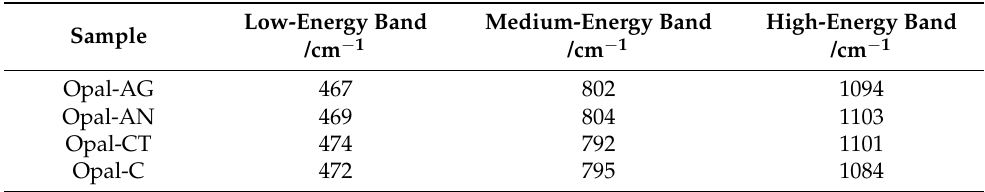
Table 4. Absorptivity index peak positions derived from the Kramers-Kronig transform of the 15 ◦ incidence angle reflection measurements for the samples shown in Figure